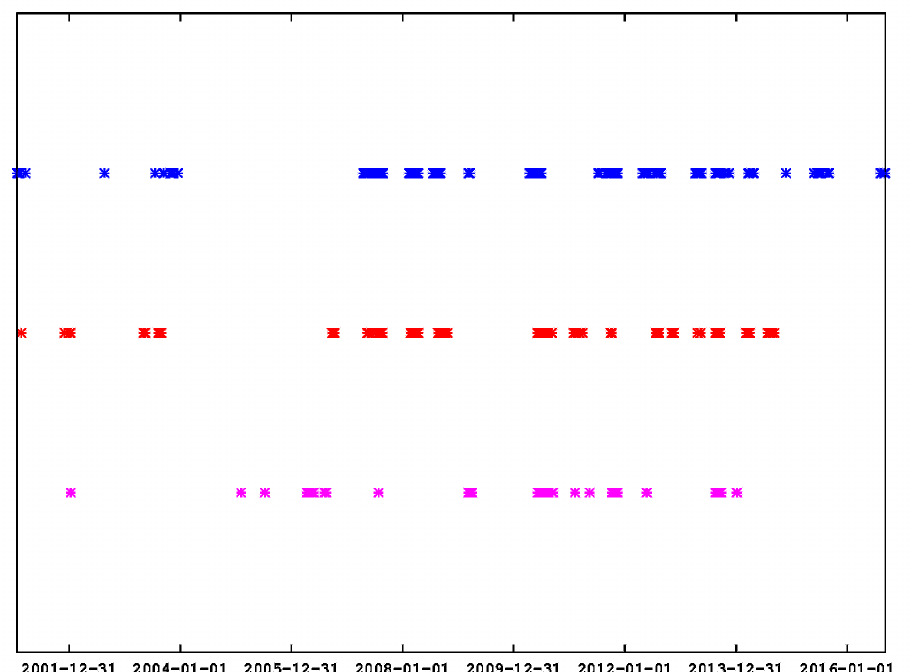
Figure 9. Common areas simultaneously identified by the methods of Higuchi, Sevcik, and R/S of Section 3 for the data of all three stations and all years in the range of 2001–2016. Colours for each station are: blue for Agia Paraskevi, red for Lykovrissi, and magenta for Maroussi. Vertical axis has no units and discriminates the common areas of the three